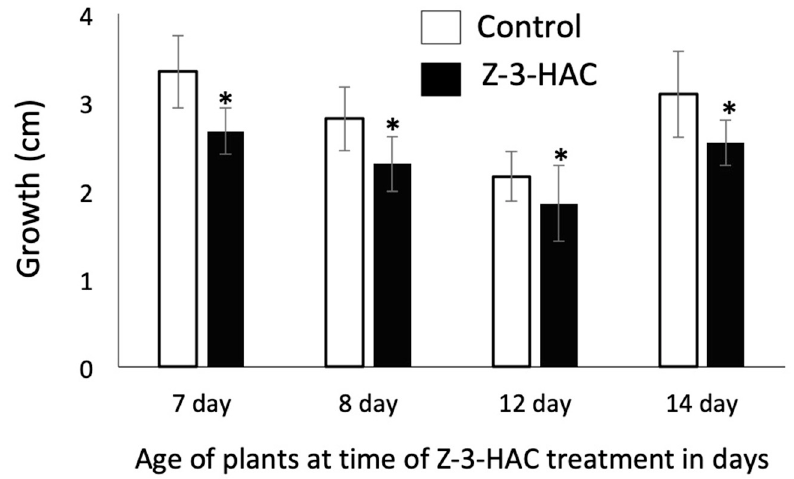
Figure 1. The effect of Z-3-hexenyl acetate (Z-3-HAC) exposure on growth in maize ( Zea mays ) seedlings ( n ≥ 15) at different ages/developmental stages. Seedlings were 7-, 8-, 12- and 14-days old when treated with physiological concentrations of Z-3-HAC (20 µ g L − 1 ) overnight (15 h). The growth of the actively growing 2nd, 3rd, 4th and 5th leaf was measured. The values are means ± SE and the asterisks indicate significant differences between control- and Z-3-HAC-treated seedlings ( t -test, P < 0.05).